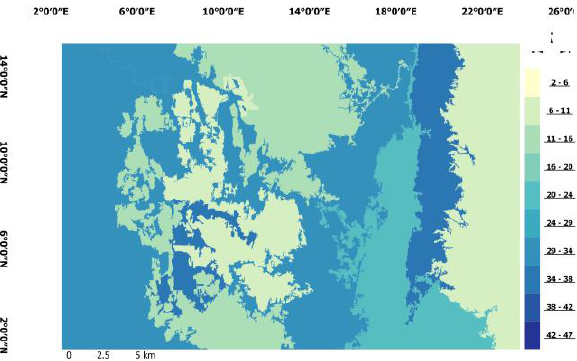
Figure 5. Object-based soil moisture map of the study area with scale parameter 1600 and average objects area of 40 km